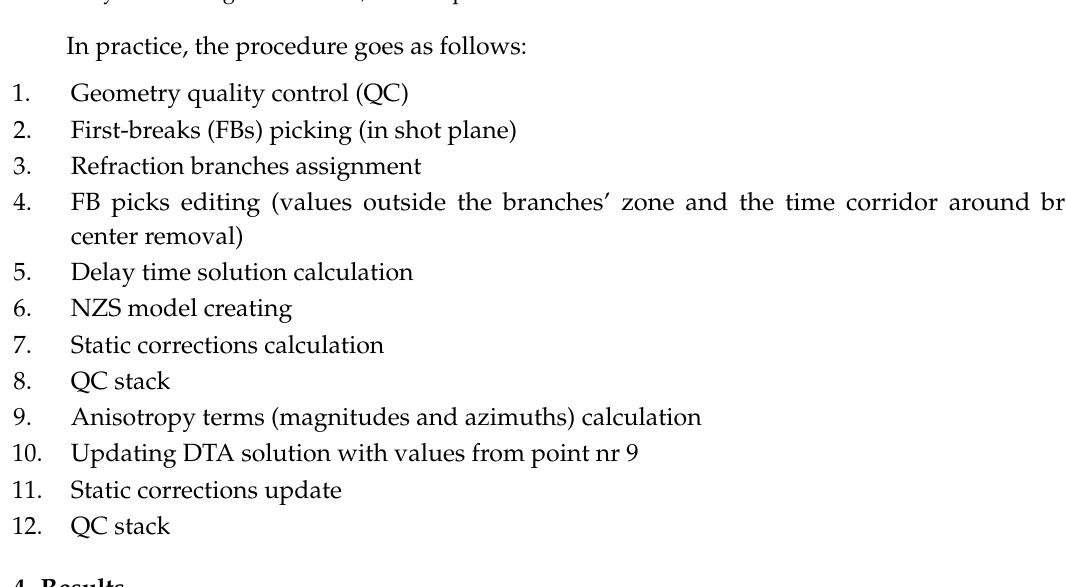
Figure 6. Three-dimensional seismic survey acquisition on the map refractor’s velocity and azimuths; the yellow triangle is a source, and the pink ovals are receivers.